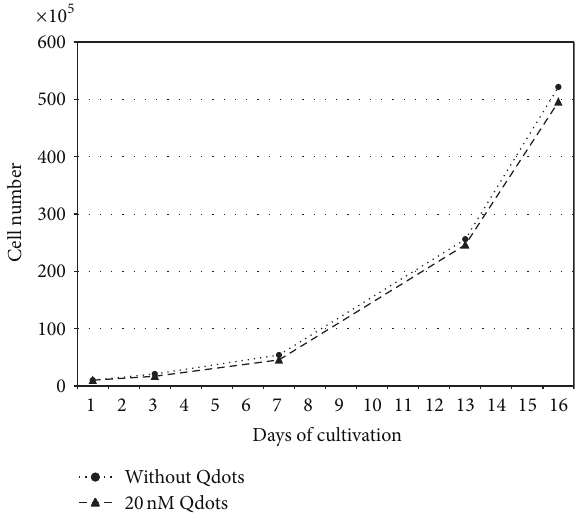
Figure 9: Long-term proliferation of a QD labeled and an unlabeled stem cell population during subcultivation within a period of 16 days. The cells were passaged and counted on days 3, 7, 13, and 16. Curve was calculated from one